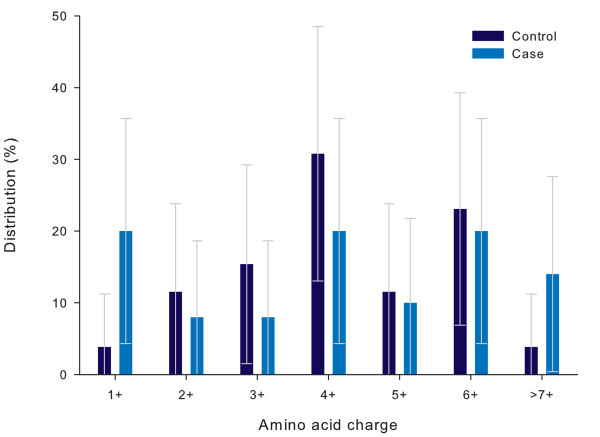
Distribution of total amino acid charge of the V1-V2-V3 fragment per study group. Distribution of the nett charges of the V1-V2-V3 fragment in children with severe anaemia (cases, Hb<5.0 g/dL) as compared to those without severe anaemia (controls). The distribution is expressed as a percentage of the total number of fragments analysed per study group (Controls: n = 26, Cases n = 25). Error bars express 95% Confidence intervals. p = 0.36.